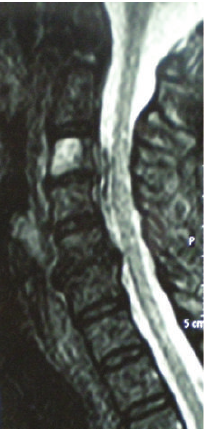
Figure 2: Preoperative MRI in sagittal plane demonstrating the spinal cord compression from a ventral C3-C4 epidural